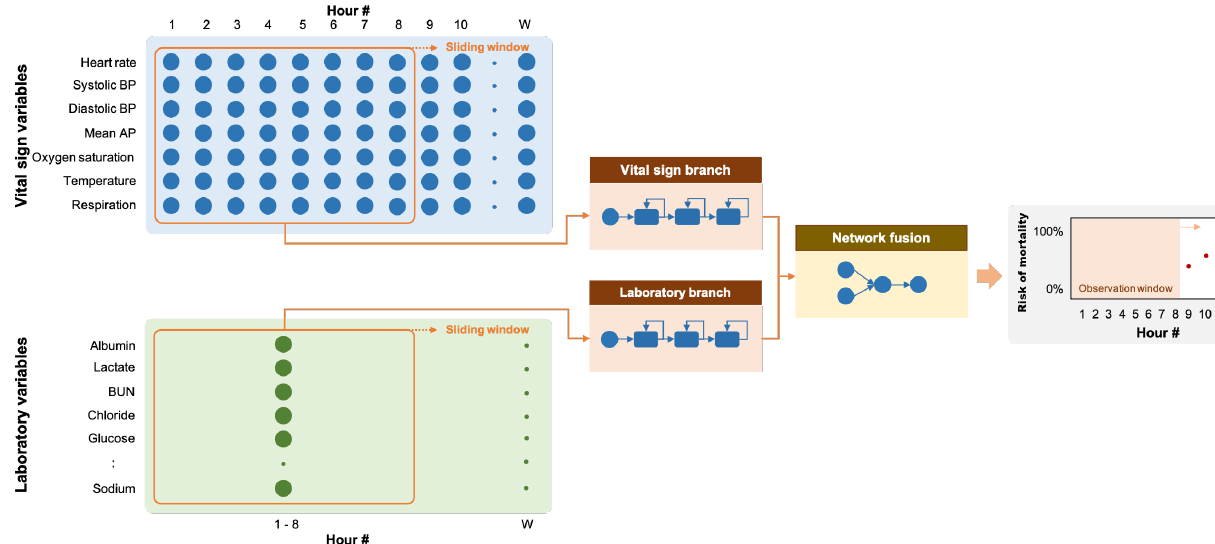
Figure 2. Diagram of our RNN model with two input branches for vital signs and laboratory variables, respectively. Each branch consists of three recurrent layers, and the resulting feature maps were fused with two fully connected layers. The network ends with a sigmoid layer for estimating a risk of mortality from 0 to